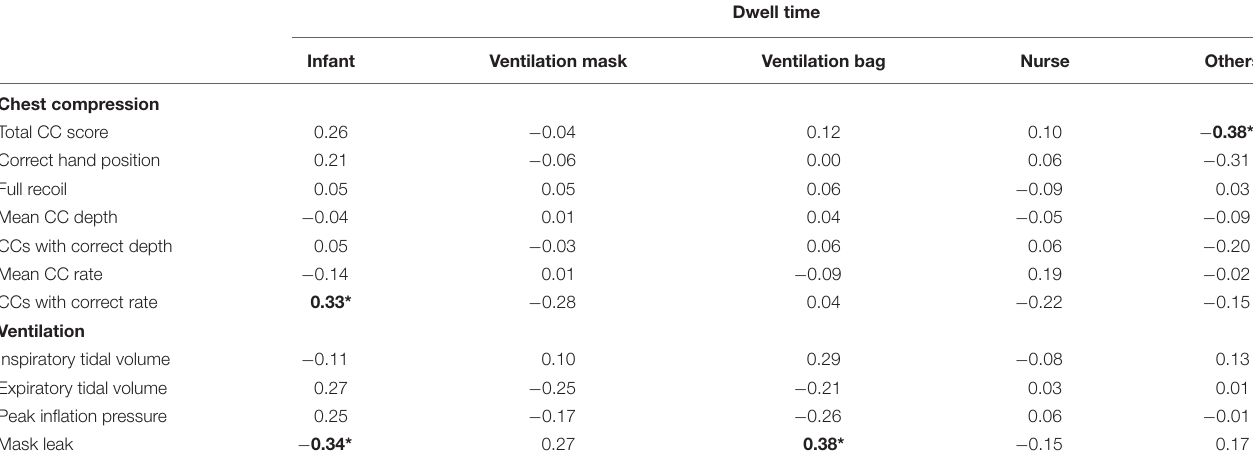
TABLE 3 | Correlations of dwell time with chest compression and ventilation